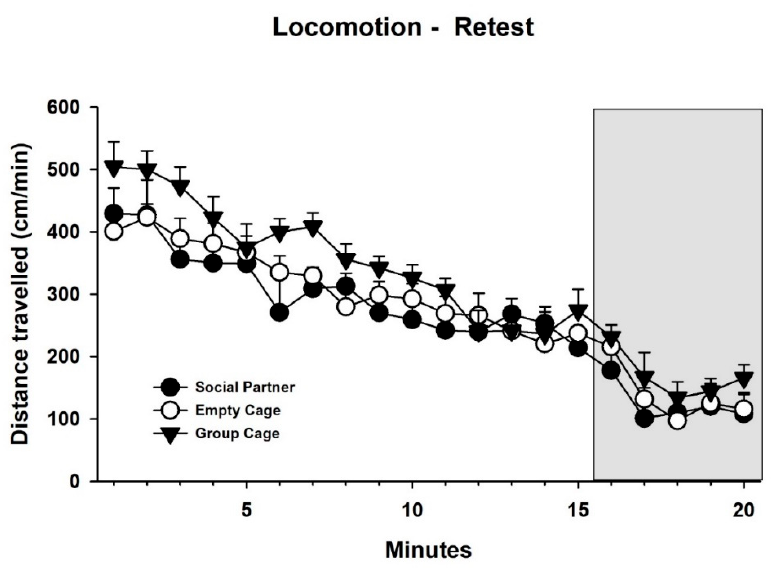
Figure 10. Locomotor activity in cm/min in the retest during the 15 min before and the 5 min during (indicated by grey background) playback in animals, which had access to a conspecific (Social Partner, black circles), no social contact (Empty Cage, white circles) or their cage mates (Group Cage, black triangles) immediately after playback in the initial test. Data are presented as means + SEM.